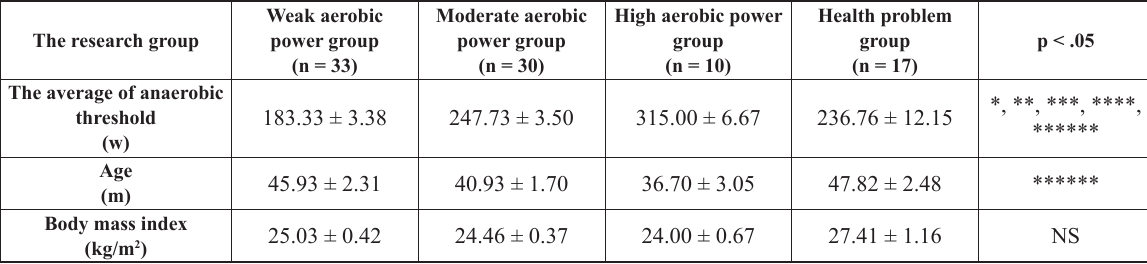
Table 1. Characteristics of the investigated continge nt The research group